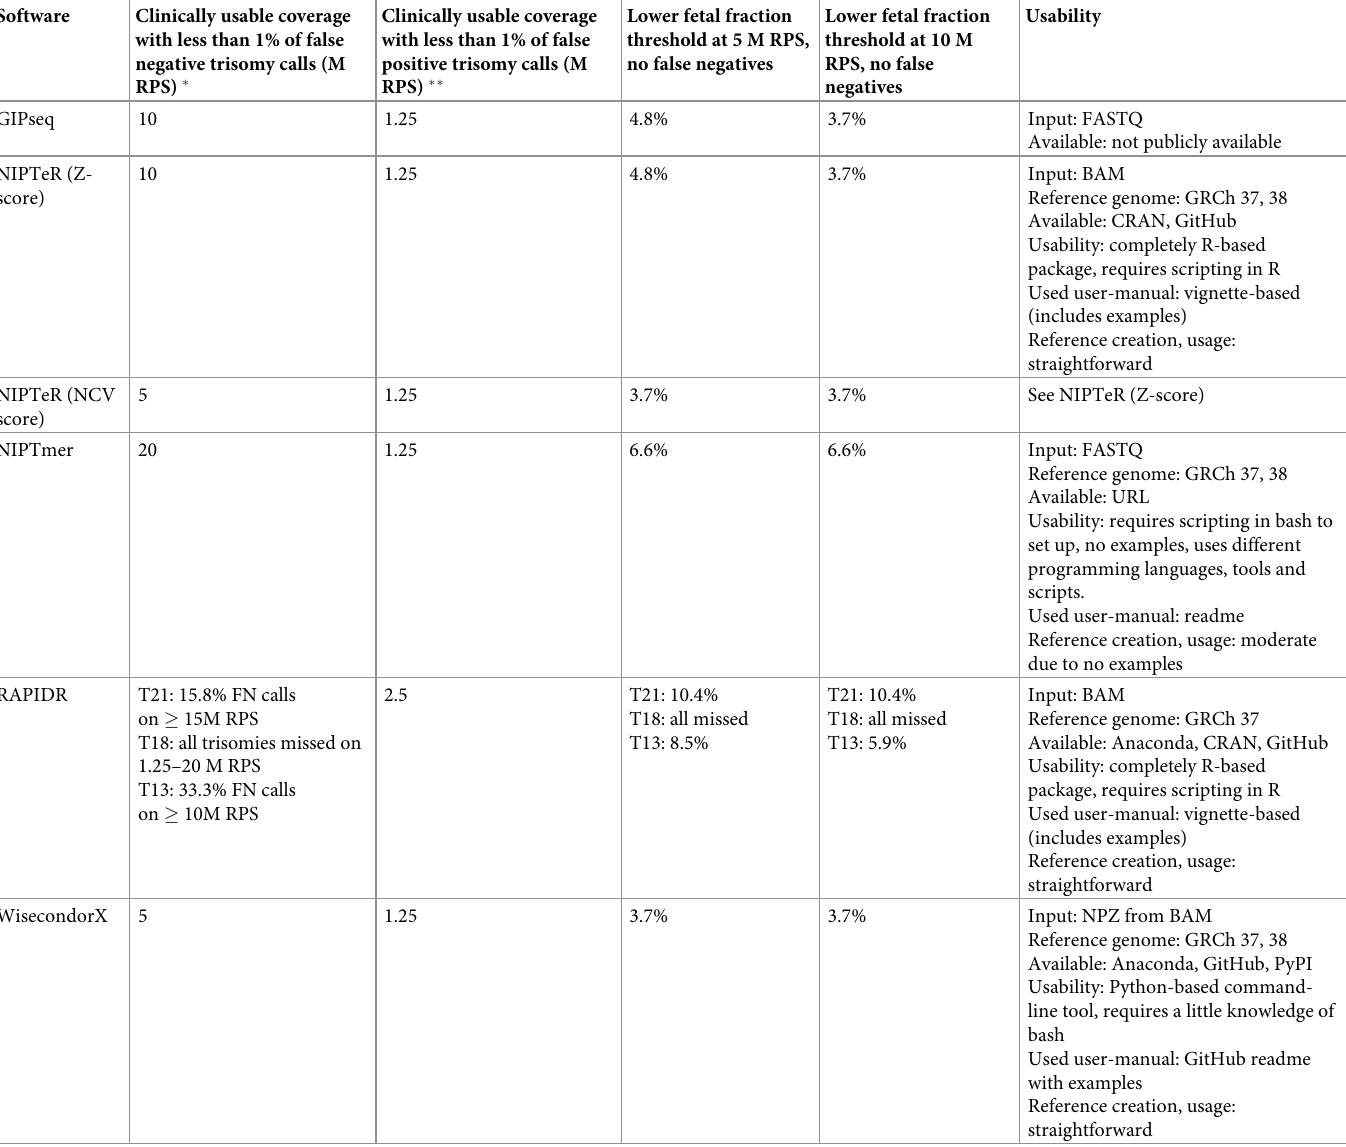
Table 1. The key considerations for each of the compared algorithms. Table covers minimal coverage where the computational tool could simultaneously detect tri- somy cases in chromosomes 13, 18 and 21 with less than 1% undetected and false-positive trisomy calls, minimal fetal fraction from which upwards there are no undetected T13, T18 and T21 calls, and software tool